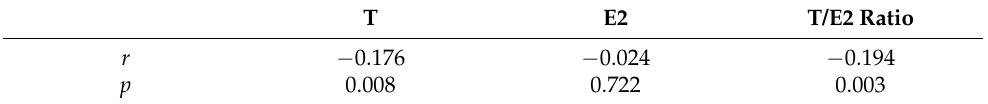
Table 2. Correlation between sex hormone and GDF-15 levels.